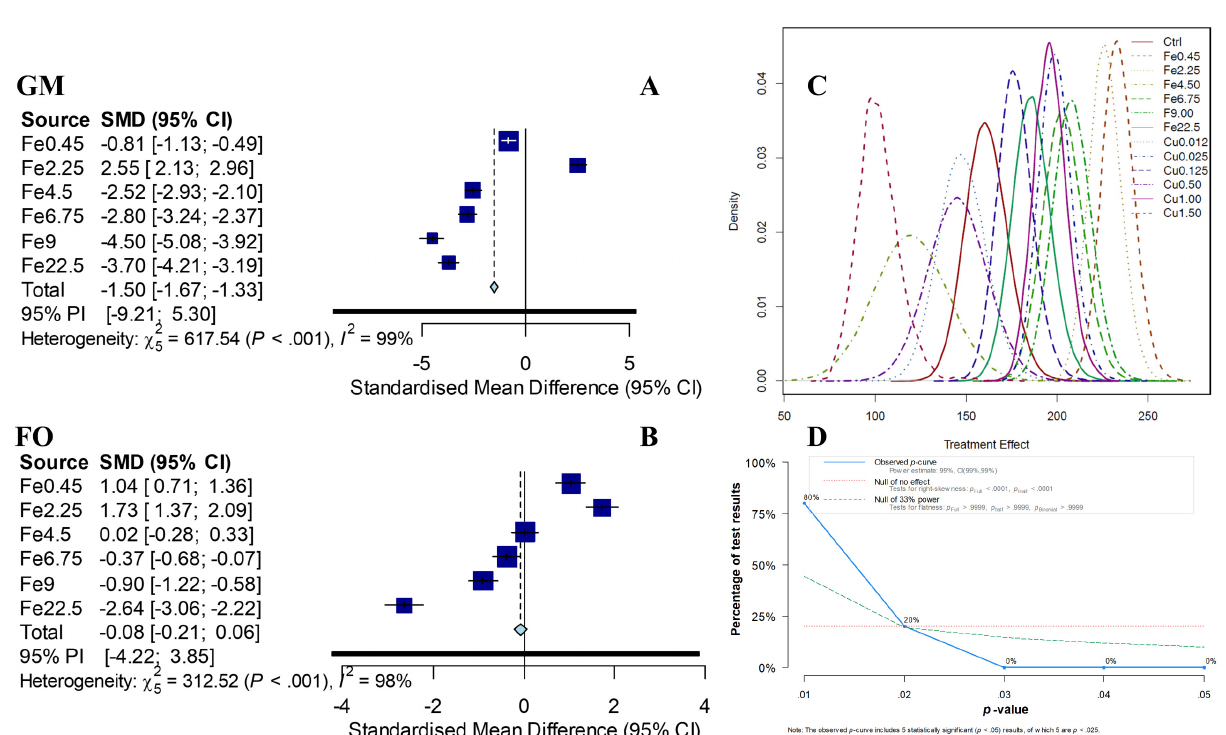
Figure 4. Prediction of the changing rate of the methane yield with different ferric dosages by the Bayesian network meta-analysis based on the biochemical methane potential at a 95% confidence level. ( a ) Gompertz model-based prediction, ( b ) first-order model-based prediction, ( c ) treatment effect density distribution of all dosages in the Gompertz model, and ( d ) p -curve. The low p -value and the impartial funnel plot indicated that the prediction is reliable in the reported case with acclimated microbes.